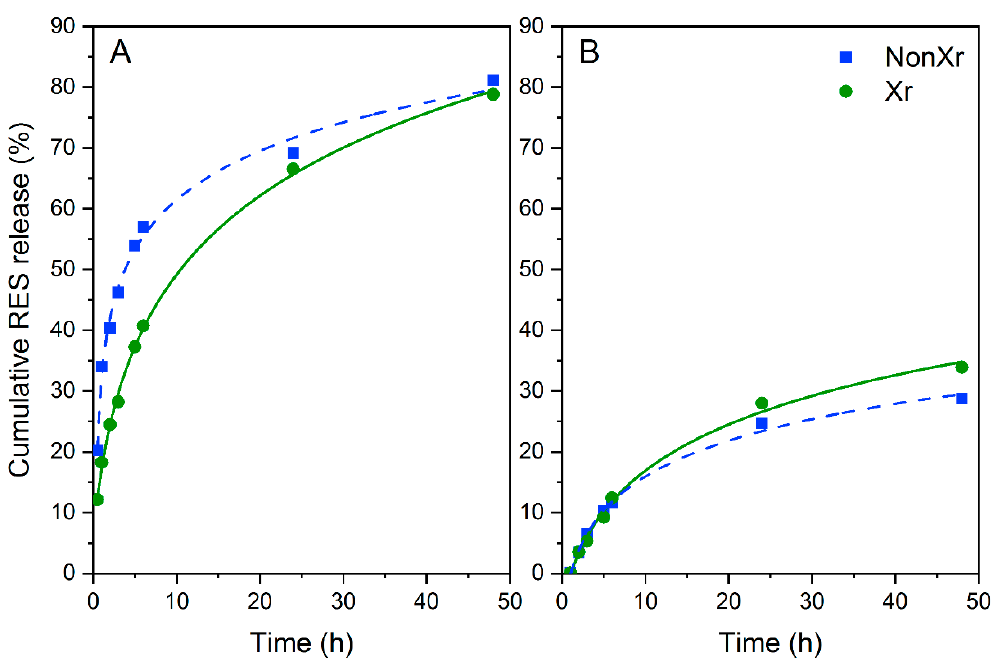
Figure 6. In vitro release profiles of resveratrol in simulated colon conditions from resveratrol-loaded NPs ( A ) and resveratrol-loaded CTS-NPs composites ( B ). The percentages of drug release were determined using Equation (1):